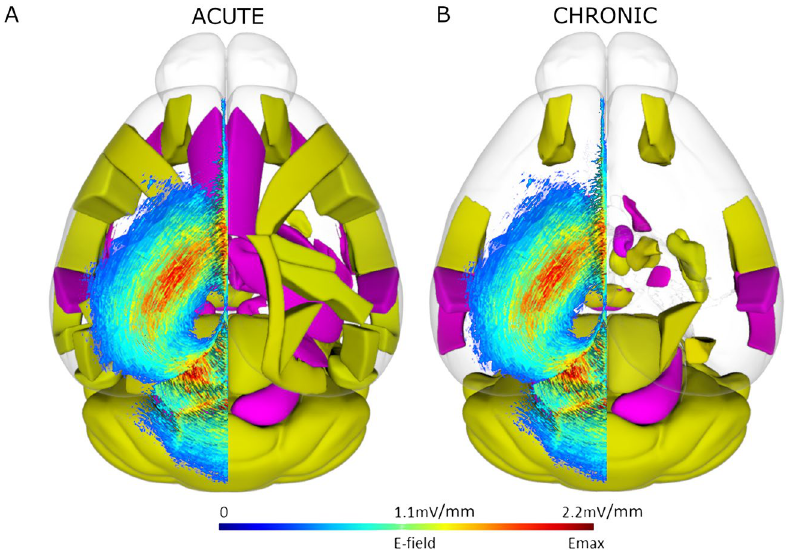
Figure 3. Spatial representation superficial brain regions with significantly modulated c-Fos density following acute ( A ) or chronic ( B ) LI-rTMS compared to the LI-rTMS-induced e-field. Left hemisphere: Simulated e-field in mV/mm induced by the LI-rTMS coil placed above lambda with a current of 1.83 mA/μs 17 . Right hemisphere: Top-down view of brain regions with significantly upregulated (yellow) or downregulated (pink) overall c-Fos density following acute ( A ) or chronic ( B ) LI-rTMS compared to sham controls. Videos showing the 3D model of significantly regulated regions can be found in supplementary materials (Movie S1–S2), and for exploration in a 3D space, 3D objects for import into the Scalable Brain Atlas Composer 34 are included on our GitHub Repository. Brain regions and outlines use data obtained from the Scalable Brain Atlas Composer 34 which uses the Allen Brain Atlas template 33 .